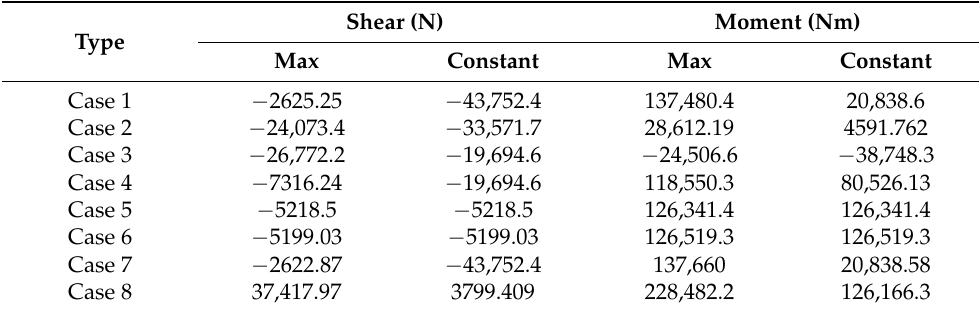
Table 5. Result force story 13 for element